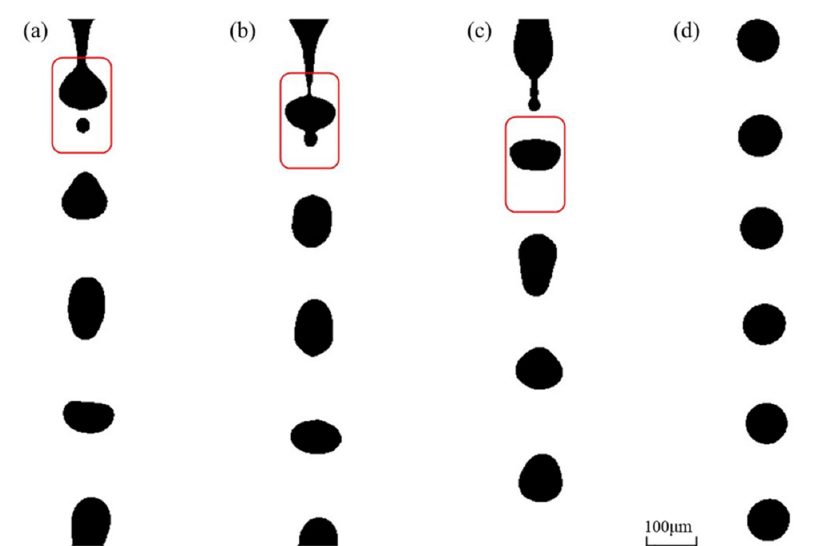
Figure 4. Snapshots of the pinch-offs of liquid filaments and the elimination of satellite droplets. ( a ) Formation of satellite droplets. ( b , c ) Satellite droplets merged by a subsequent mother droplet and eliminated; ( d ) a highly uniform size distribution of monodisperse droplets were obtained (volume flow rate of 30 mL/h; pulse frequencies of 30 kHz).